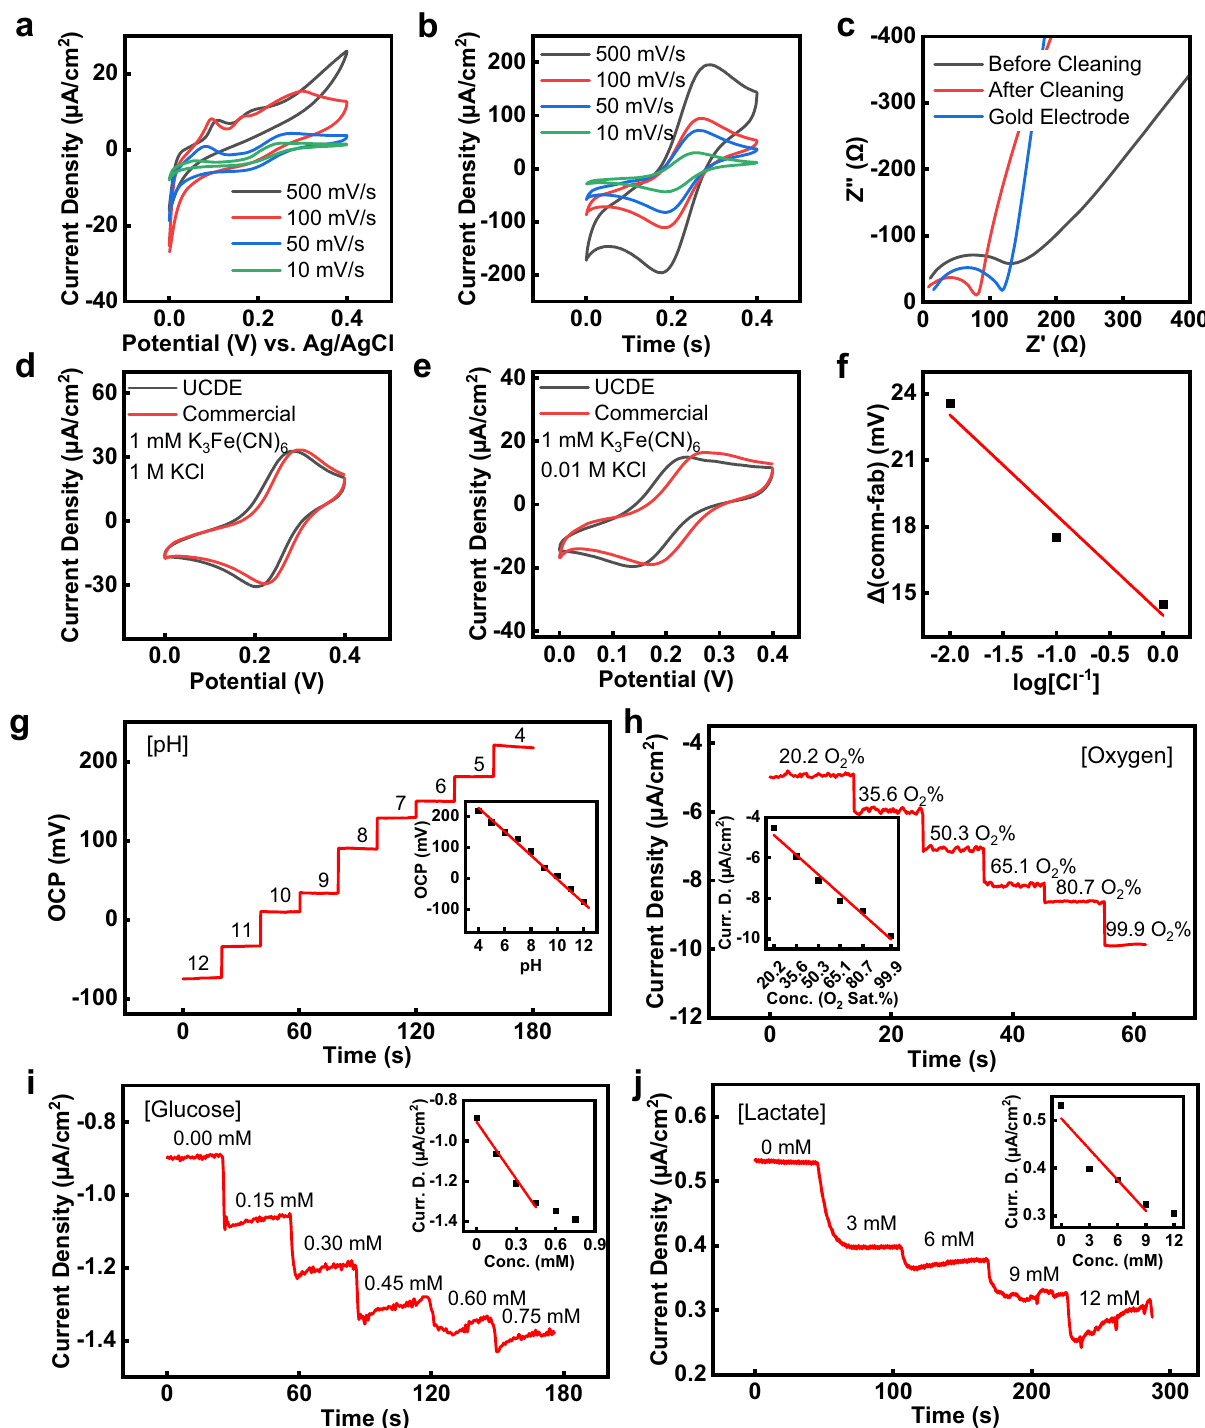
Fig. 4 Characteristics of the stretchable, electrochemical UCDEs. Cyclic voltammetry of UCDEs vs. Ag/AgCl (1 M KCl) in PBS (pH 7.4) with 5 mM K 3 Fe(CN) 6 a before and b after electrochemical cleaning in H 2 SO 4 . c EIS performance in PBS (pH 7.4) with 5 mM K 3 Fe(CN) 6 . Cyclic voltammetry performance of UCDEs as a Ag/AgCl reference electrode vs commercial Ag/AgCl (1 M KCl) electrode with d 1 M and e 0.01 M Cl − . f Calibration curve of the UCDE reference electrode compared to a commercial Ag/AgCl (1 M KCl) electrode. g Potentiometric performance of the UCDE as a pH sensor (vs. fabricated Ag/AgCl UCDEs reference electrode). Inset is the associated calibration curve of the pH sensor. Amperometric performance of the UCDEs as a h oxygen, i glucose, and j lactate sensor (vs. fabricated Ag/AgCl UCDEs reference electrode). Insets are the corresponding calibration